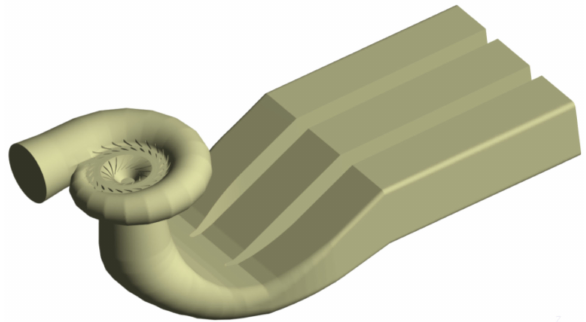
Figure 3. Example of full turbine simulation domain